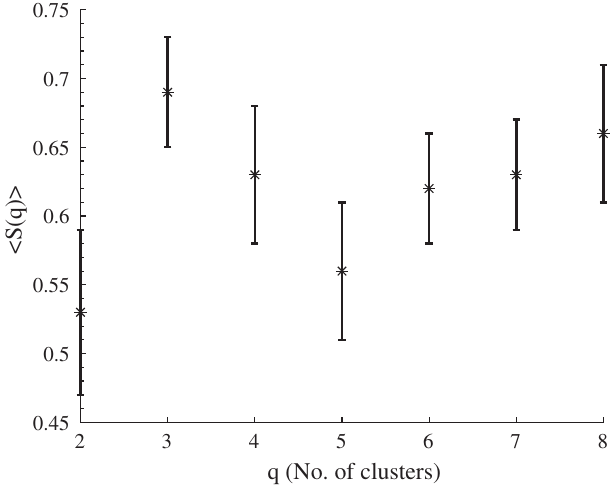
FIG. 4. Average silhouette values and related 95% CI for different cluster partitions of our sample. The highest values are obtained for partitions in q ¼ 3 clusters h S ð 3 Þi ¼ 0 . 69 , CI ¼ ð 0 . 65 ; 0 . 73 Þ .